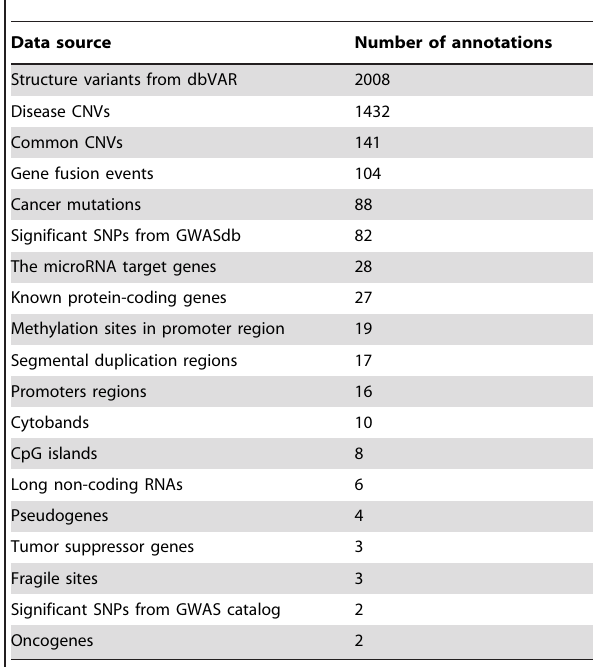
Figure 4. An example of the CNVannotator region-based search result layout. After successfully uploading a CNV list(s), a set of annotations are overlapped to the input CNVs and are represented in by hyperlinks to the UCSC Genome Browser. Additionally, the tabular text file is available to download for further filtering and classification. doi:10.1371/journal.pone.0080170.g004 Table 2. The annotation results for the top ten novel CNVs from microsatellite stable hereditary nonpolyposis colorectal cancer samples using the CNVannotator web